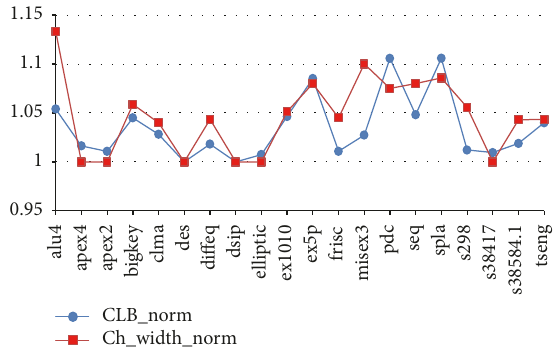
Figure 9: Number of LUTs missed for cluster size 𝑁 = 16 and 𝑝 = 3 for 𝑑 = 3 and 4. Figure 10: Impact of high CLB usage on channel